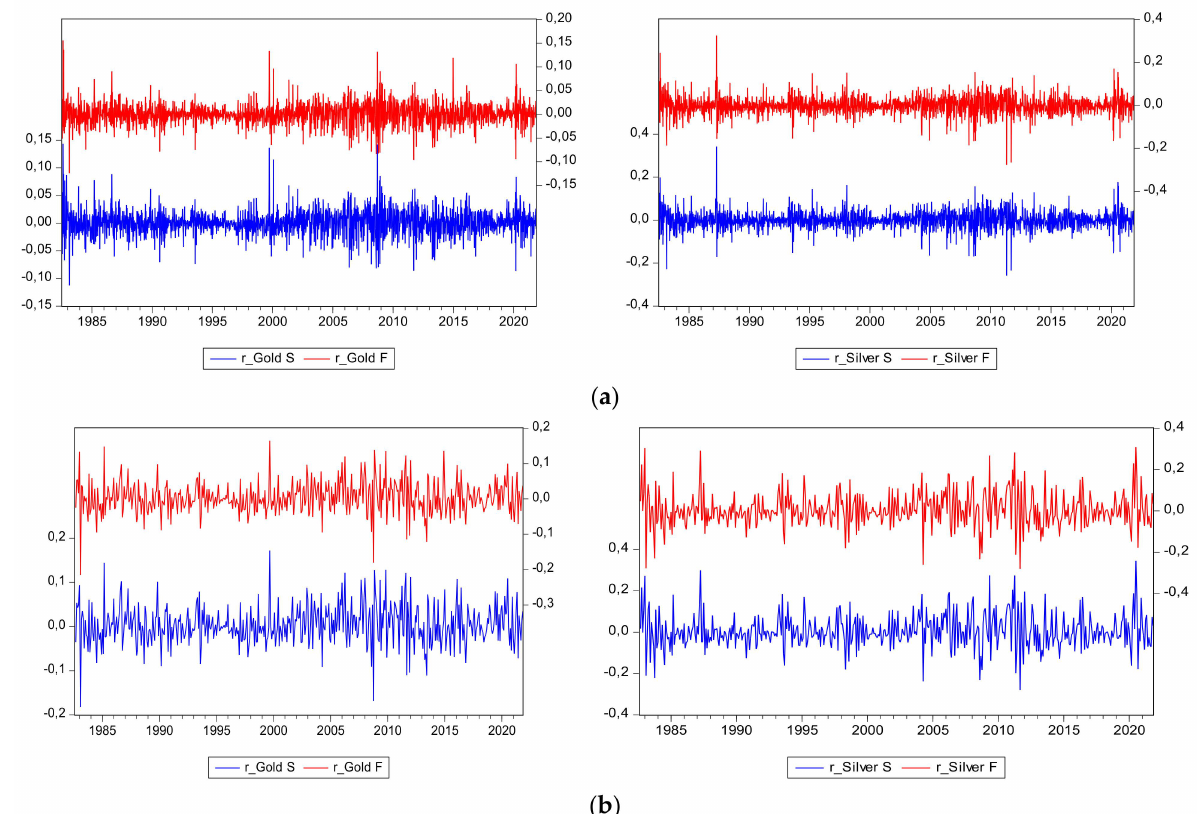
Figure 2. ( a ) Weekly Returns. ( b ) Monthly